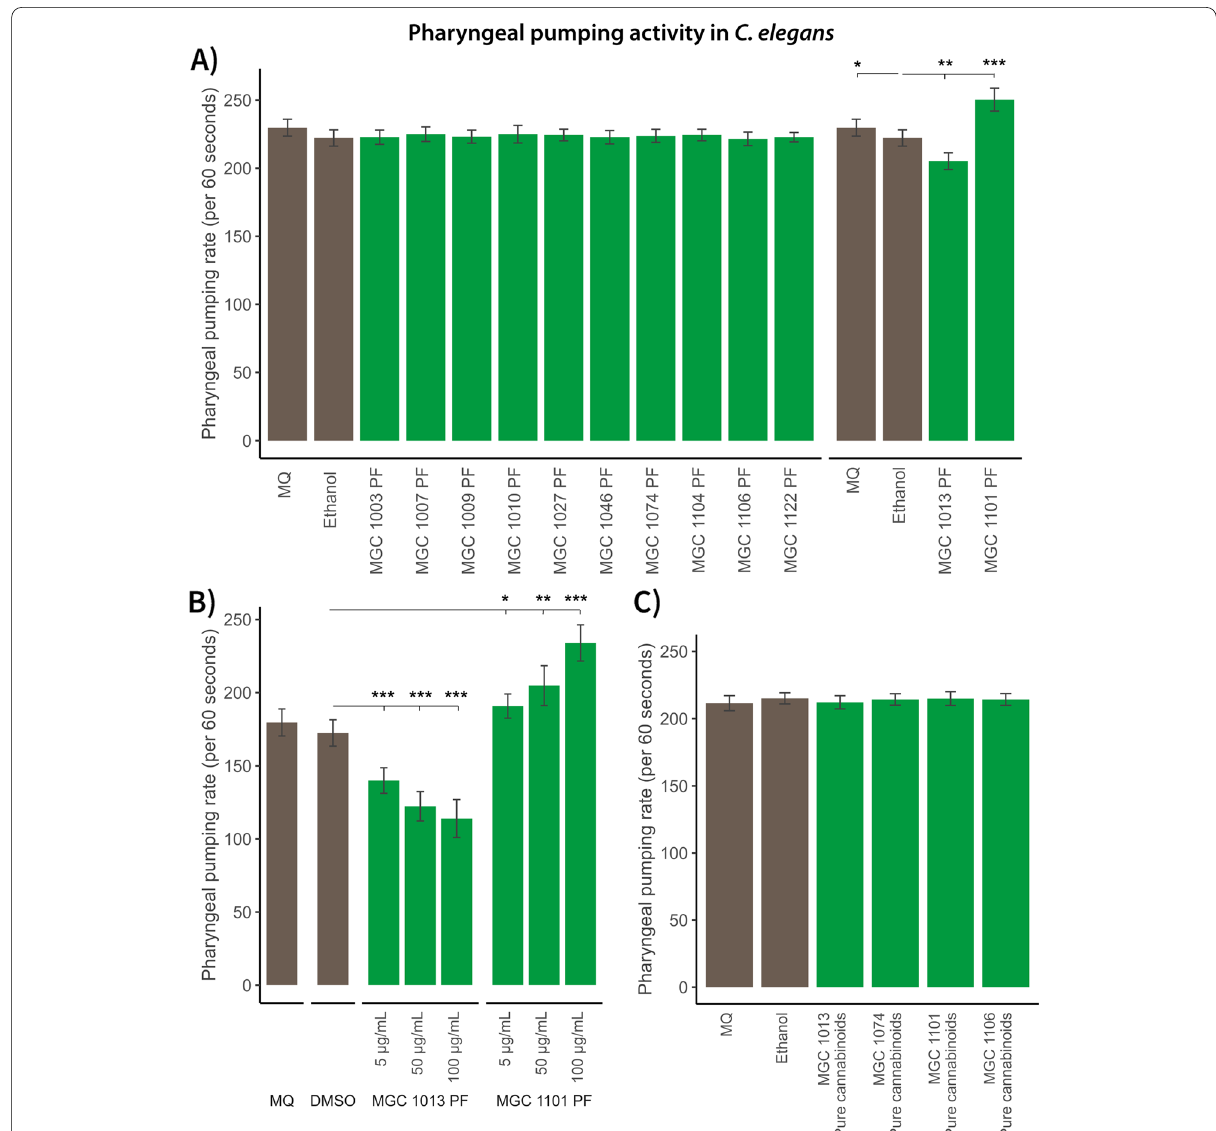
Fig. 3 Effect of polar fractions (PFs) of different cannabis varieties on pharyngeal pumping activity in C. elegans . The nematode C. elegans was exposed to the PFs from different cannabis varieties as well as pure cannabinoids. A Overview of pharyngeal pumping activity of 100 μg/mL PF of all cannabis varieties used in this study; B dose‑response with 5, 50, and 100 μg/mL PF extracts of the two varieties MGC 1101 and MGC 1013 that showed an effect on the pharyngeal pumping activity; C : pharyngeal pumping activity in nematodes treated with pure cannabinoids containing 0.0143 μg/mL cannabidiol (CBD) (similar to the concentration in the polar fraction (PF) of MGC 1101), pure cannabinoids containing 0.0125 μg/ mL CBD (similar to the concentration in the PF of MGC 1074), pure cannabinoids contain 0.0262 ug/mL Δ 9 ‑tetrahydrocannabinol‑acid (THCA) and 0.0133 μg/mL Δ 9 ‑tetrahydrocannabinol (THC) (similar to the concentration in the PF of MGC 1101), and pure cannabinoids contain 0.0278 μg/mL THCA and 0.0140 μg/mL THC (similar to the concentration in the PF of MGC 1106). Mann‑Whitney U tests ( A ) and t tests ( B ) were used to compare the vehicle control conditions ethanol ( A ) and Dimethyl sulfoxide (DMSO) ( B ) to the experimental conditions. Milli‑Q water (MQ) is the water control in A and B. Green bars denote pharyngeal pumping activity in C. elegans exposed to polar fractions (PFs) of cannabis; brown bars denote vehicles; *** false discovery rate (FDR)‑corrected p < .001; ** FDR‑corrected p < .01; * FDR‑corrected p < = = =